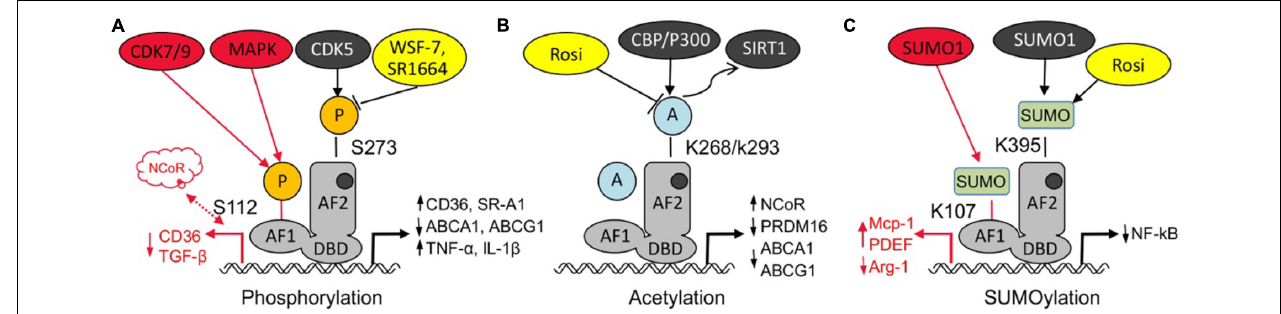
FIGURE 2 | Post-translational modification of PPAR γ regulates atherosclerosis. (A) Both phosphorylation of PPAR γ at S112 by CDK7/9 or MAPK and phosphorylation of PPAR γ at S273 accelerates foam cell formation and atherosclerosis through different signaling pathway, some PPAR γ agonist (WSF-7, SR1664) can block cdk5 mediated Ser273 phosphorylation. (B) Acetylation of PPAR γ at K268/K293 increases atherosclerosis through upregulating ABCA1, ABCG1, and NcoR but inhibiting PRDM16,while deacetylation of PPAR γ at K268 and K293 alleviates atherosclerosis, while PPAR γ agonist rosiglitazone (Rosi) could deacetylate PPAR γ at K268/K293. (C) Sumoylation of PPAR γ at K107 promotes VSMCs proliferation and migration, but sumoylation of PPAR γ at K395, such as by Rosi, has anti-inflammation